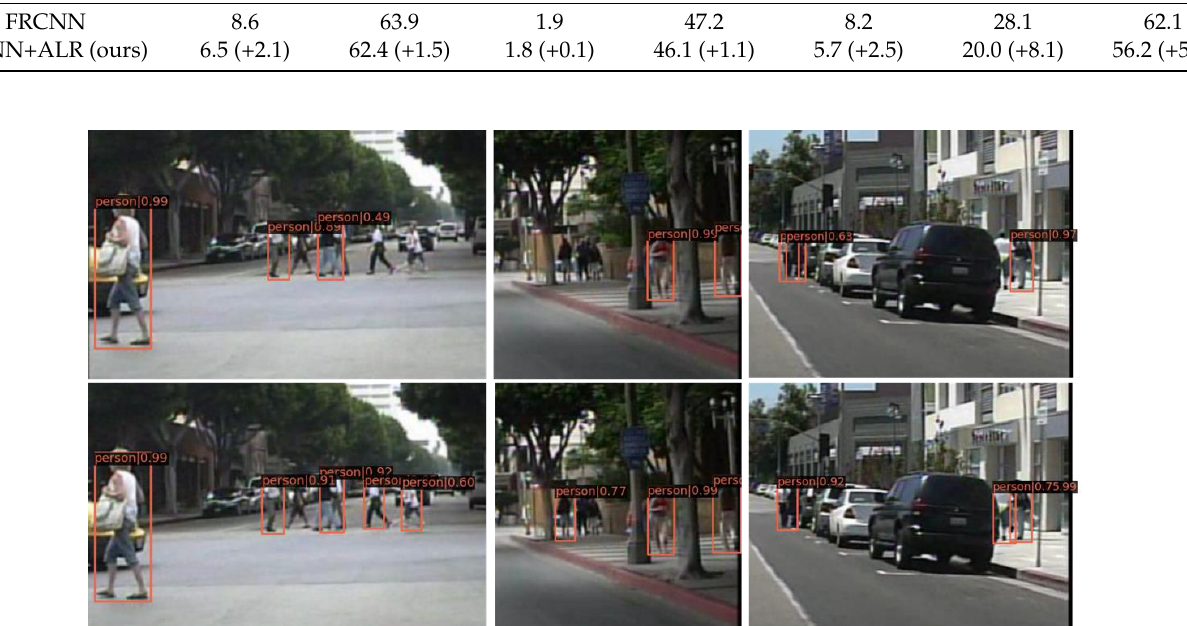
Figure 7. Qualitative results from the baseline method ( the first row ) and our FRCNN+ALR ( the second row ) in the Caltech-USA testing